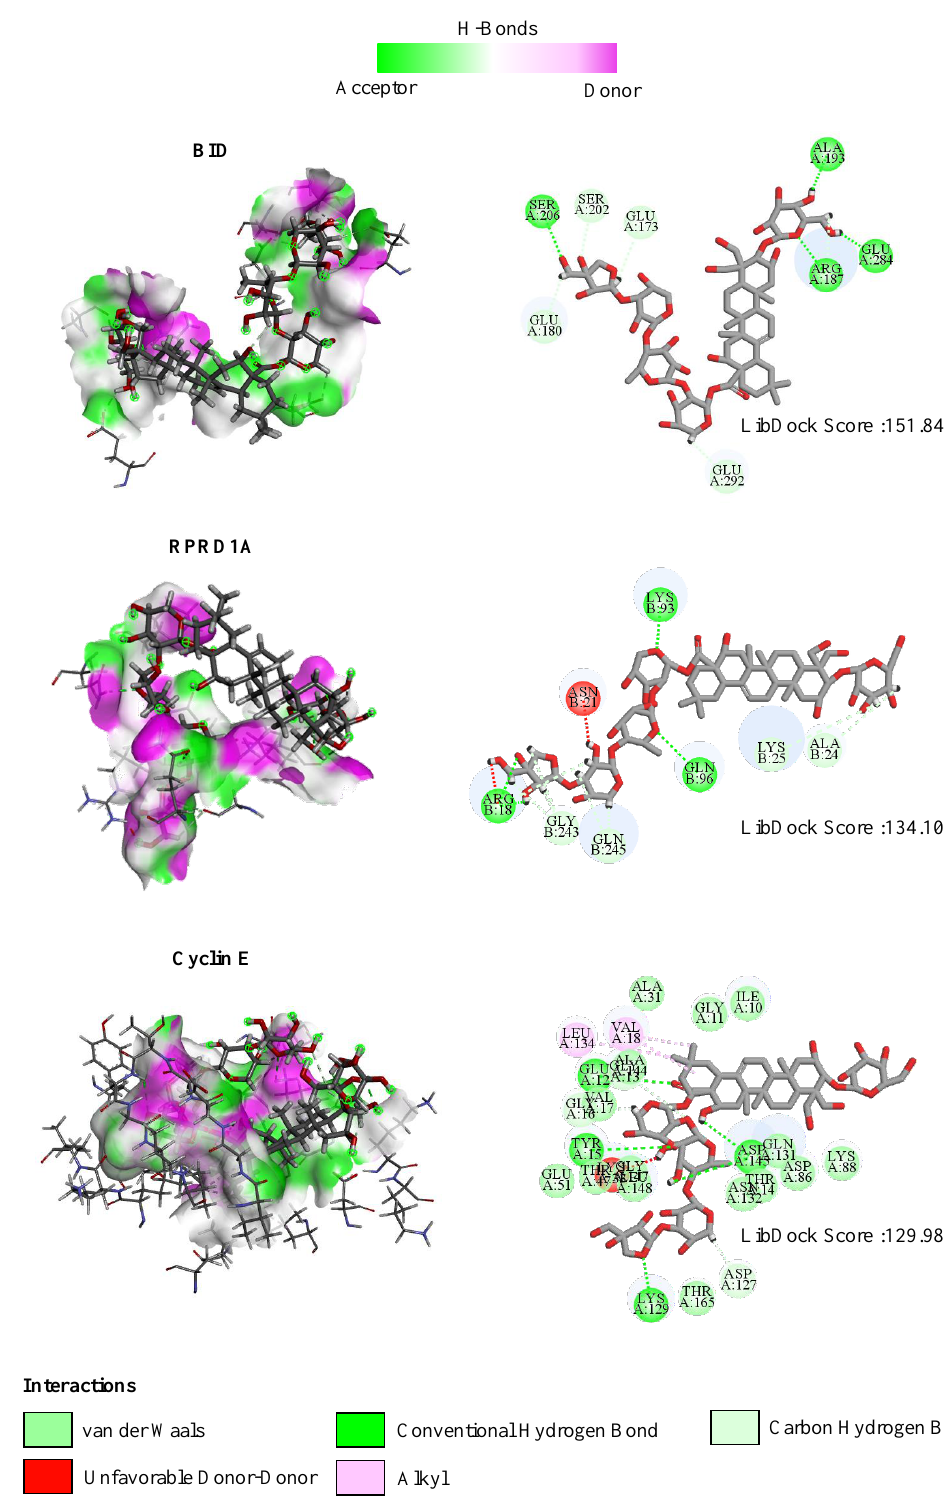
Figure 10. The interactions between PD and target proteins. The interactions between PD and BID, RPRD1A, and Cyclin E proteins are shown. In H-bonds, pink indicates the donor and green indicates the receptor. In the interactions, green indicates van der Waals interactions, dark green indicates conventional hydrogen bonds, light green indicates carbon–hydrogen bonds, dark red indicates unfavorable donor–donor interactions, and pink indicates alkyl interactions. The LibDock scores are calculated by Discovery Studio